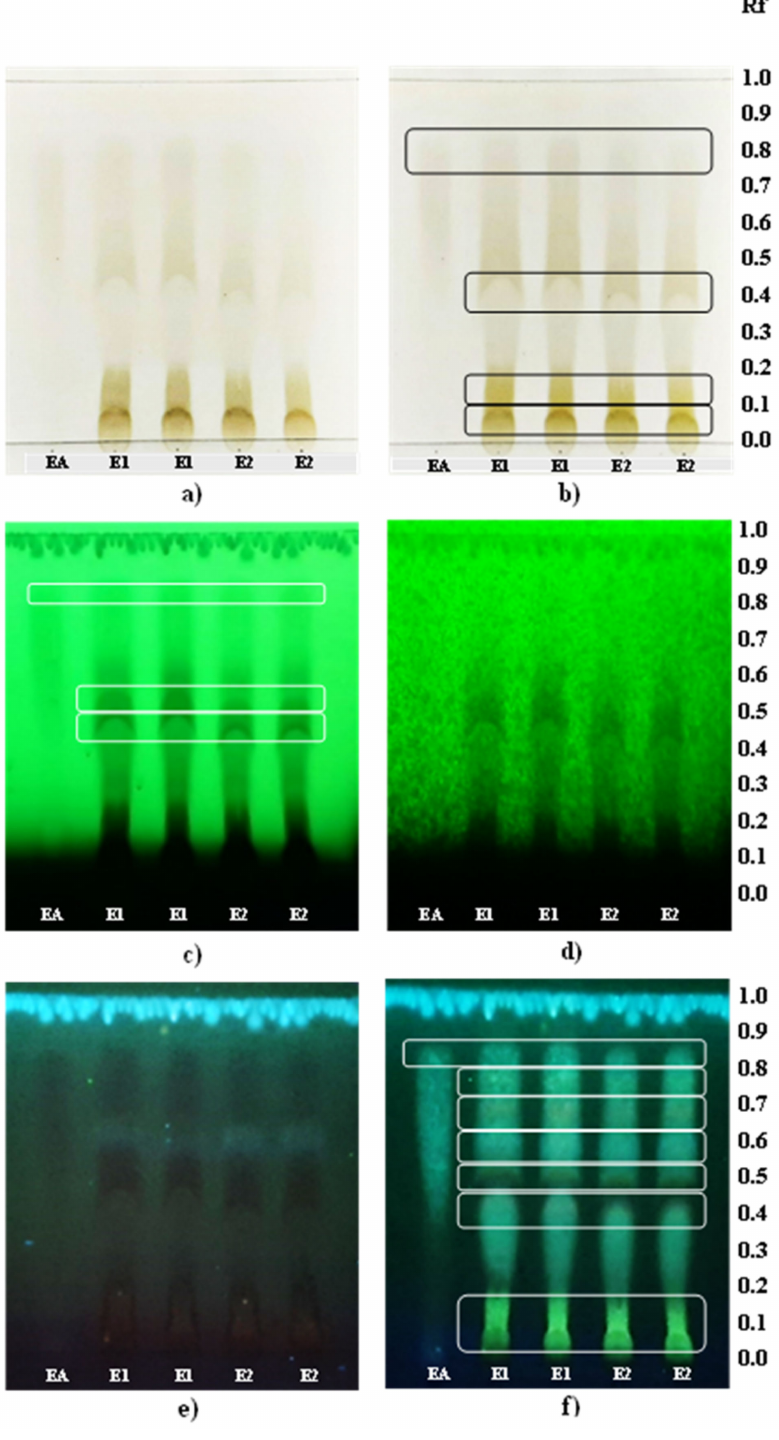
Figure 2. TLC analysis of extracts E1 (40 bar) and E2 (80 bar) under ( a ) visible light without NP, ( b ) visible light with NP, ( c ) UV light at 254 nm without NP, ( d ) UV light at 254 nm with NP, ( e ) UV light at 366 nm without N, and ( f ) UV light at 366 nm with